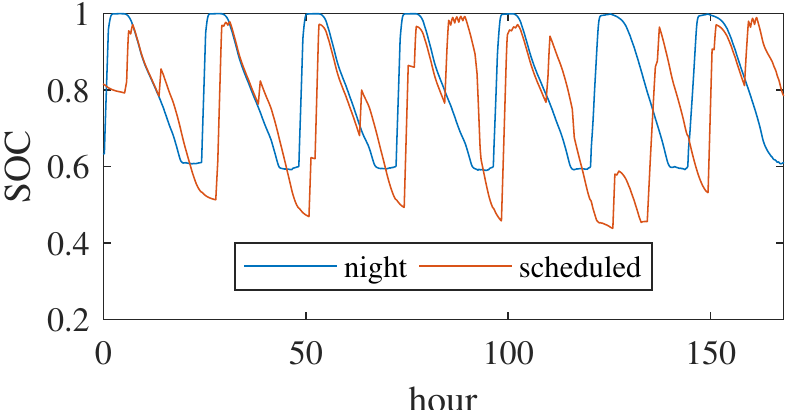
Figure 10. Average SoC of the fleet during a week in scenario DE-S for the night charging strategy and the proposed scheduled strategy.